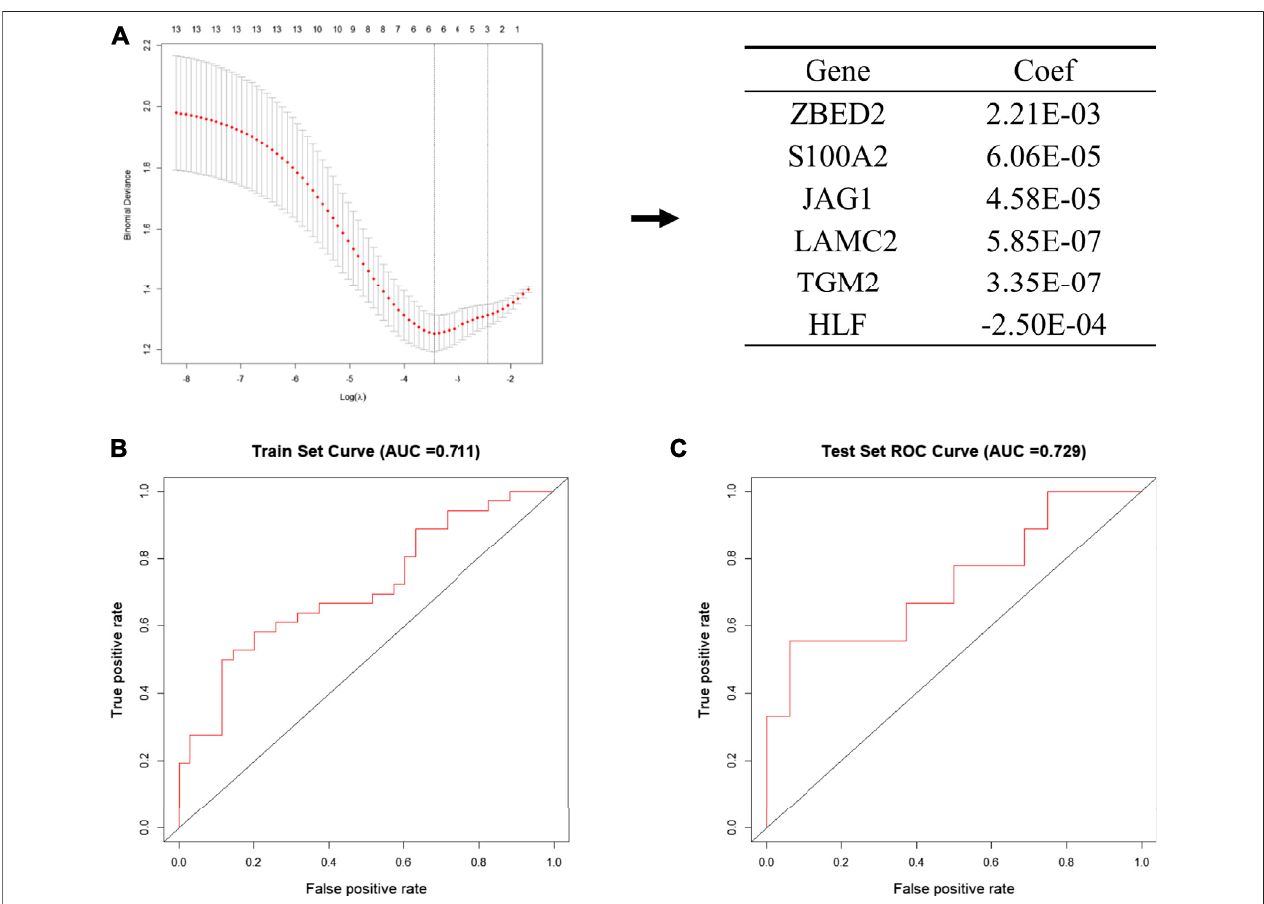
FIGURE4| Establishmentofthemetastaticsignaturebasedonthesixselectedgenes (A) Schematicrepresentationofthemodelbuildingprocess.Intheleftpane, the13genesthatwereusedtoconstructthemodelsareshown,amongsixgeneswereselectedaccordingtotheminimumbinomialdeviance.Therightpanelshowsthe coef fi cients of six genes screened by Lasso (B, C) The ROC curve of risk signature of train set (B) and test set (C) of LASSO risk scoring model.